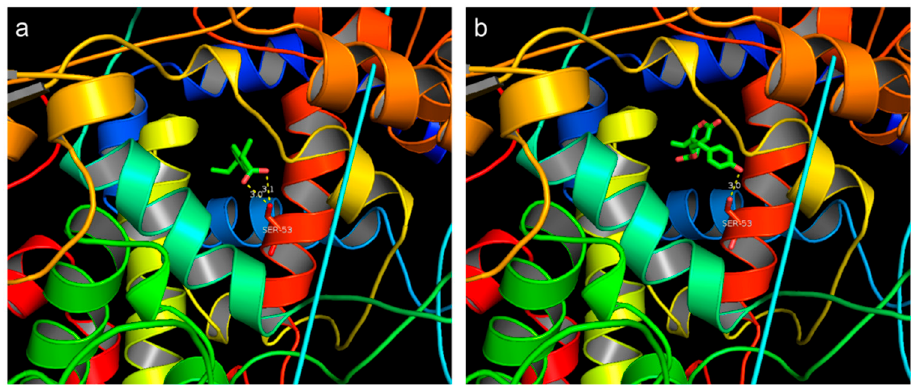
Figure 3. Molecular docking results of ( a ) ibuprofen and ( b ) oleocanthal compared to cyclooxygenase-2 (COX-2). The dashed line represents hydrogen bonds and distance (Å).